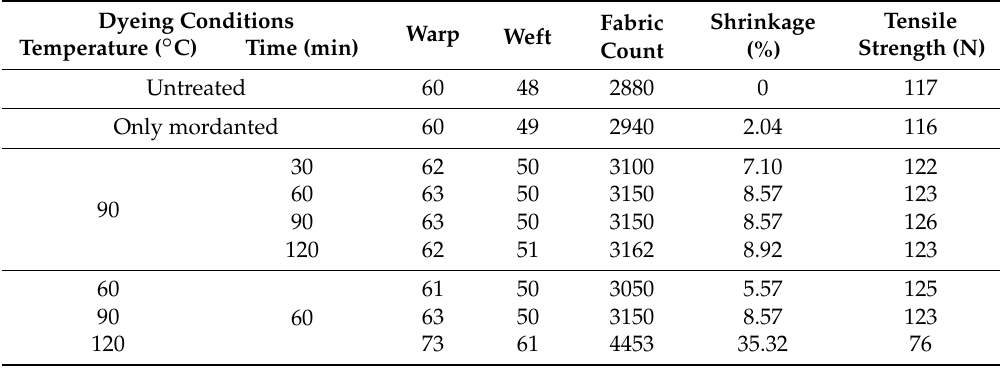
Table 3. Shrinkage and tensile strength of wool fabrics dyed with spent coffee extract and mordanted with 1 wt % tannic acid aqueous solution.